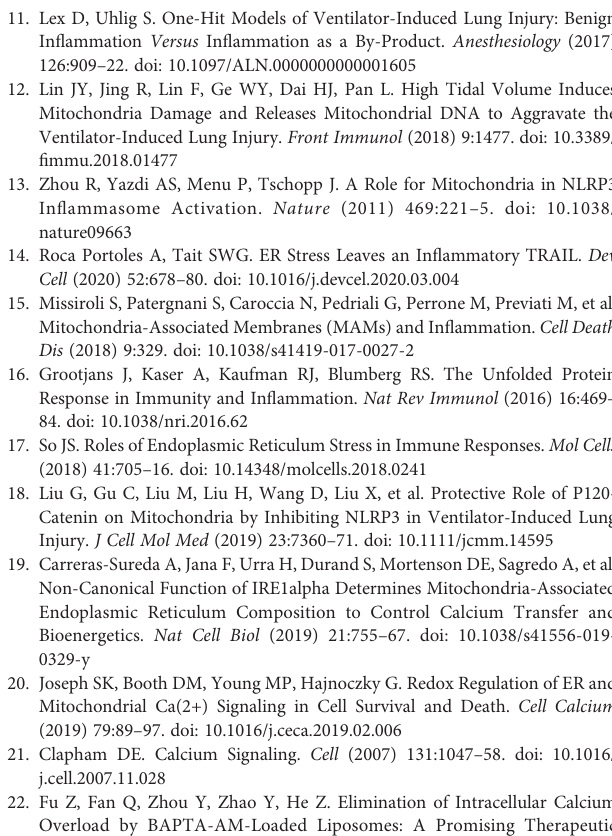
Supplementary Figure 1 | Assessment of the dose-dependent effects of BAPTA-AM on cytoplasmic Ca2+ levels. (A, B) Fluo-4 AM labeling and quanti fi cation analysis in group CON and HTV mice and HTV-treated mice administered with BAPTA-AM with 1.25, 2.5 and 5 mg/kg respectively. Data are expressedasmeans±SD(n=6pergroup).* P <0.05 vs .CON group. # P <0.05 vs . HTV group. Supplementary Figure 2 | Evaluation of the cytotoxic effects of carbachol on MLE12 and RAW264.7 cells. (A) Cell viability of MLE12 and RAW264.7 cells after treating with different doses of carbachol as observed by CCK8 assays. (B) Morphological changes and reduced cell populations of MLE12 and RAW264.7 cells treated with different concentrations of carbachol. Scale bar: 200 m m. (C) Detection of apoptotic MLE12 and RAW264.7 cells after 50 m M carbachol by fl ow cytometry based-annexin V- FITC/PI analysis. Data are expressed as means ± SD from 3 independent experiments. * P < 0.05 vs . Mock